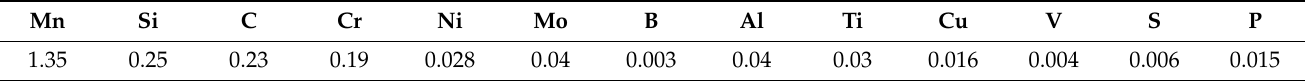
Table 1. Chemical composition of BR1500HS (wt